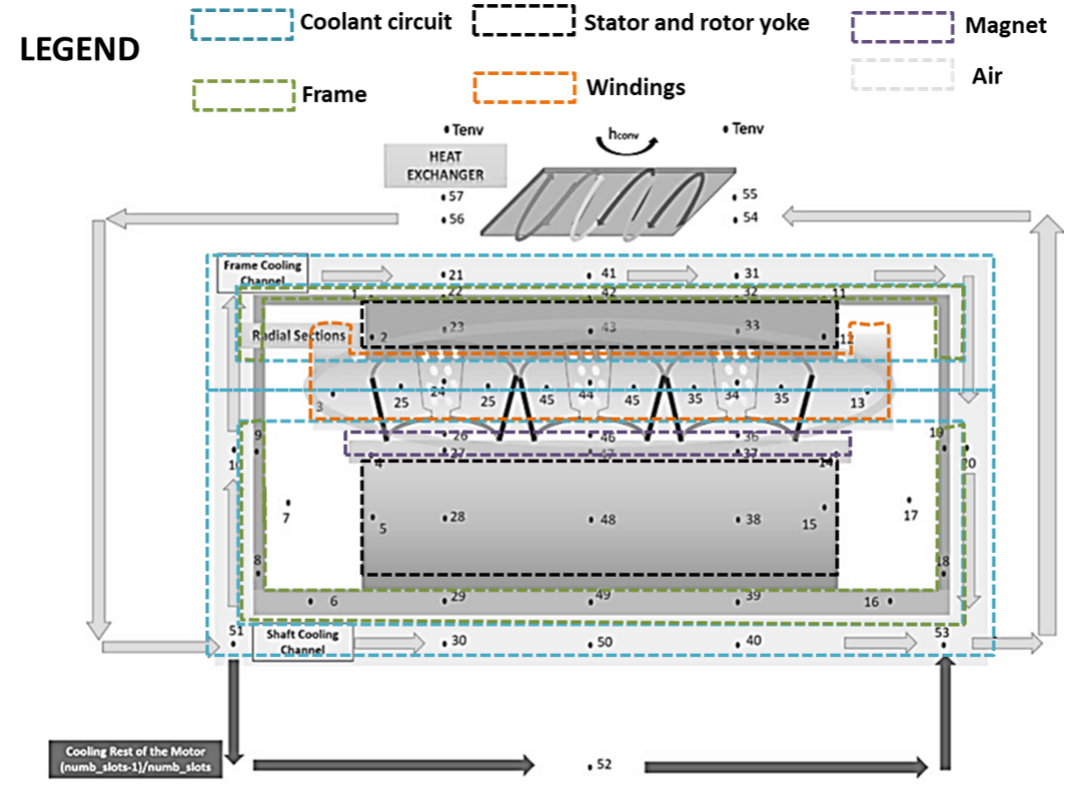
Figure 10. Cooling system nodal network represented at different locations in the machine.